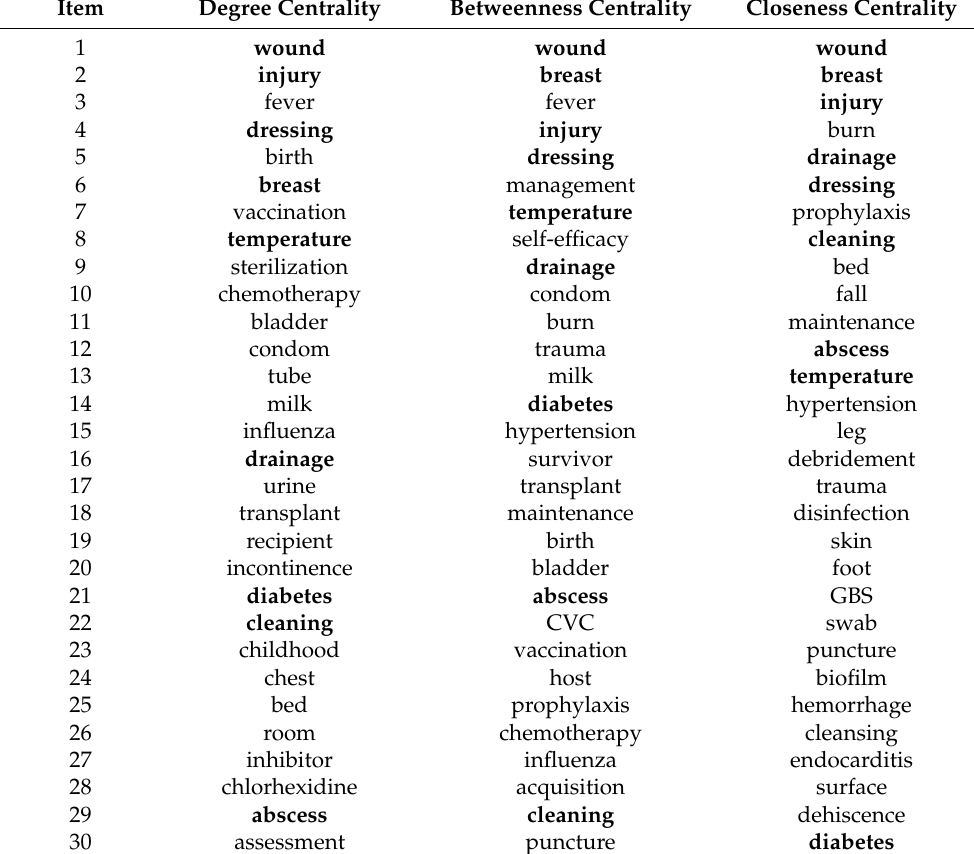
Table 3. Keywords from network